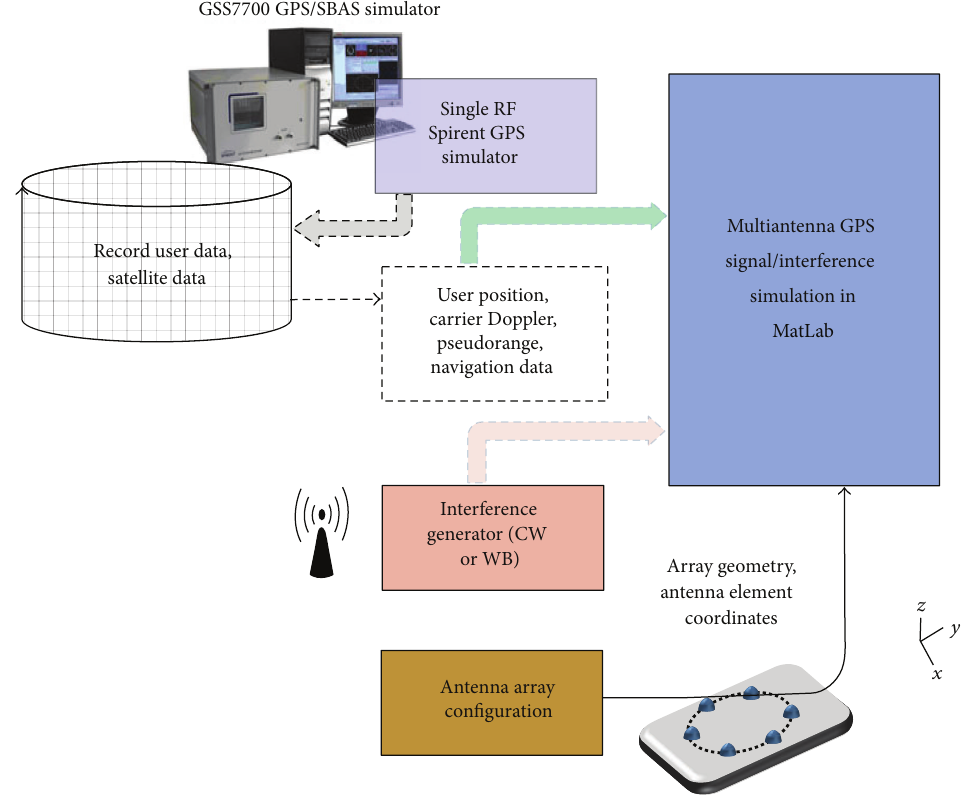
Figure 1: Multiantenna GPS-interference simulation